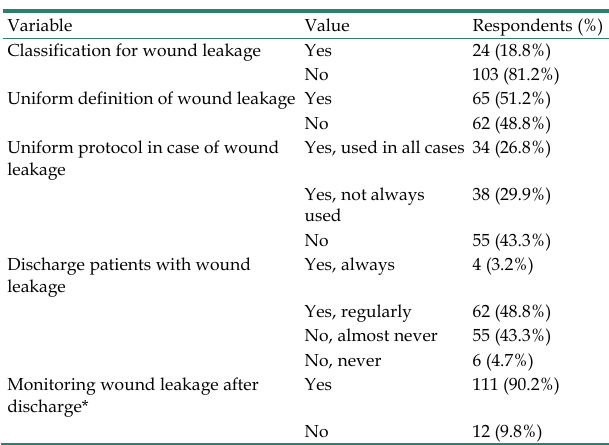
Table 2. Definition, classification and protocol for wound